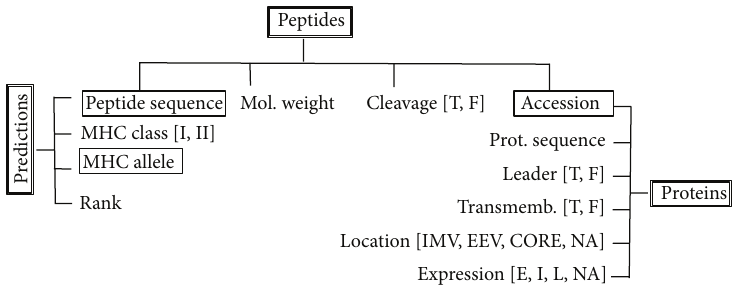
Figure 1: EPIPOX database structure. EPIPOX is a relational database consisting of three main tables: peptides , predictions , and proteins . Table names are boxed with double lines. For each table, we show their fields and boxed with single lines the fields that work as table keys. For fields taking discrete nominal values, we show them between square